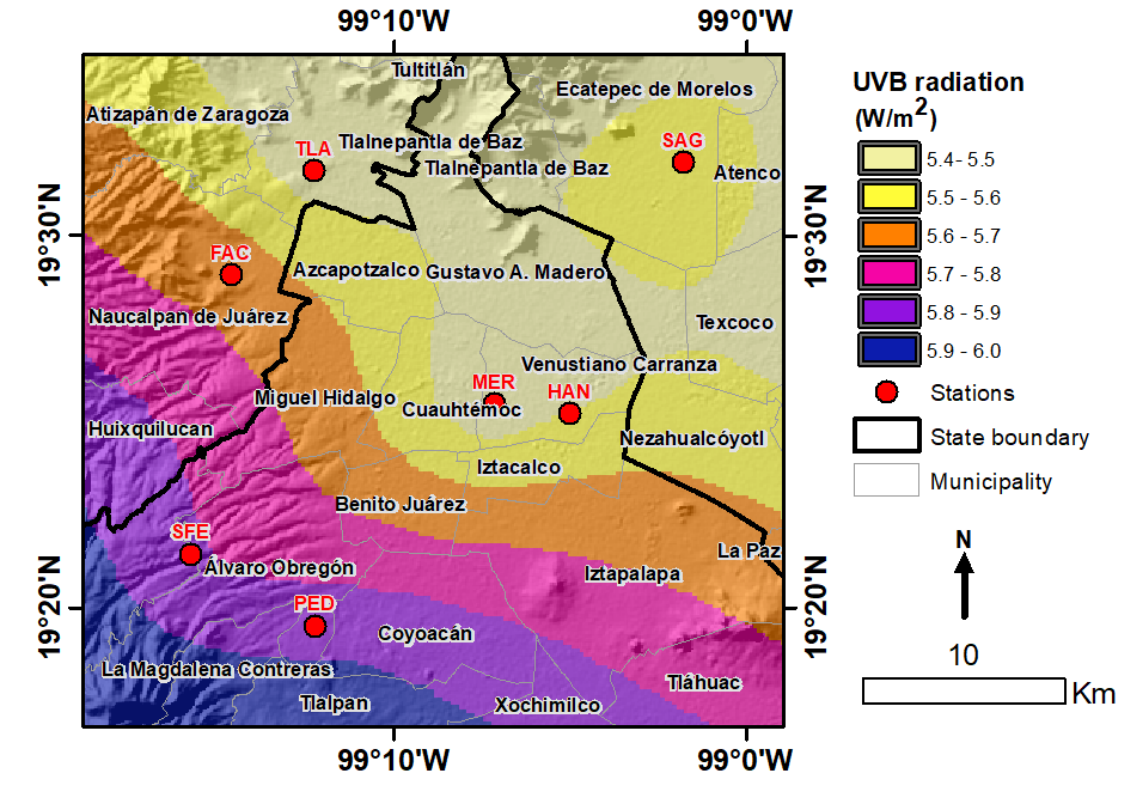
Figure 7. Spatial distribution of 25-year return period extreme UVB radiation estimation in North Mexico